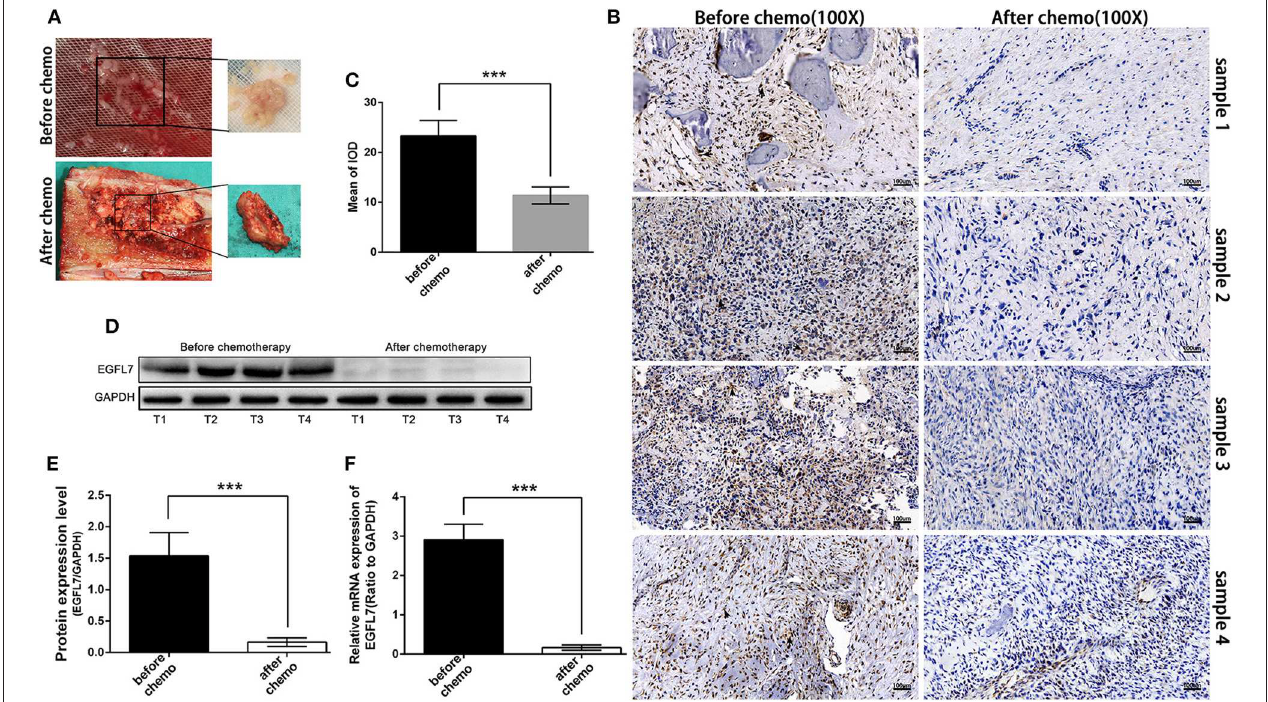
FIGURE 5 | Chemotherapy deregulated expression of EGFL7 in osteosarcoma. (A) Samples obtained by biopsy before chemotherapy and by tumor resection after chemotherapy in the same patient. Pre-chemotherapy tissue specimens showed fish-like appearance, while post-chemotherapy tumor tissue showed obvious bone repair changes. (B,C) Immunohistochemical staining of the same patient’s tumors before and after chemotherapy showed that there was almost no expression of EGFL7 in the tumors after chemotherapy (black arrows represent positive areas). The semi-quantitative statistical analysis based on IHC results shows that there is a significant difference in the expression of EGFL7 between pre-chemotherapy and post-chemotherapy. (D,E) Western blot results showed that EGFL7 protein was almost no expression in post-chemotherapy tissue compared with pre-chemotherapy tissue, Student’s t -test shows that the difference has obvious statistical significance. (F) RT-PCR results showed that the transcription level of EGFL7 mRNA in post-chemotherapy tissue was significantly deregulated than that in pre-chemotherapy tissue, and the difference was statistically significant. * P < 0.05, ** P < 0.01, *** P < 0.001.